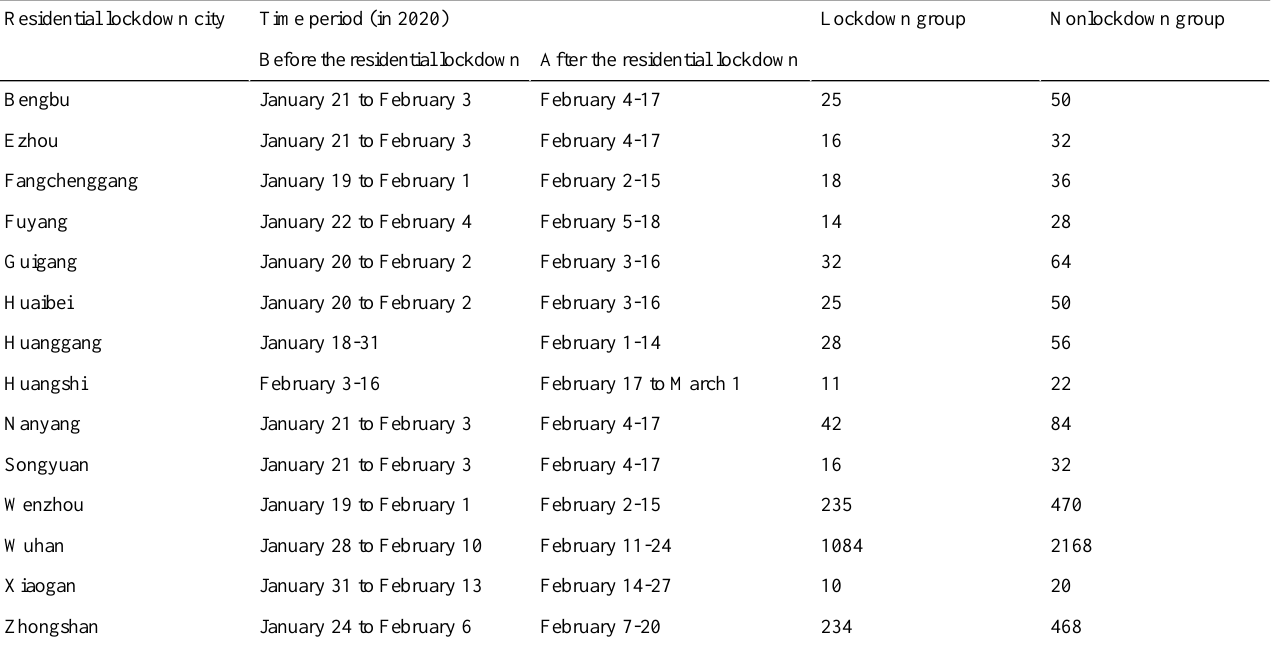
Table 2. Numbers of users in each group in the final sample and corresponding time periods of data extraction